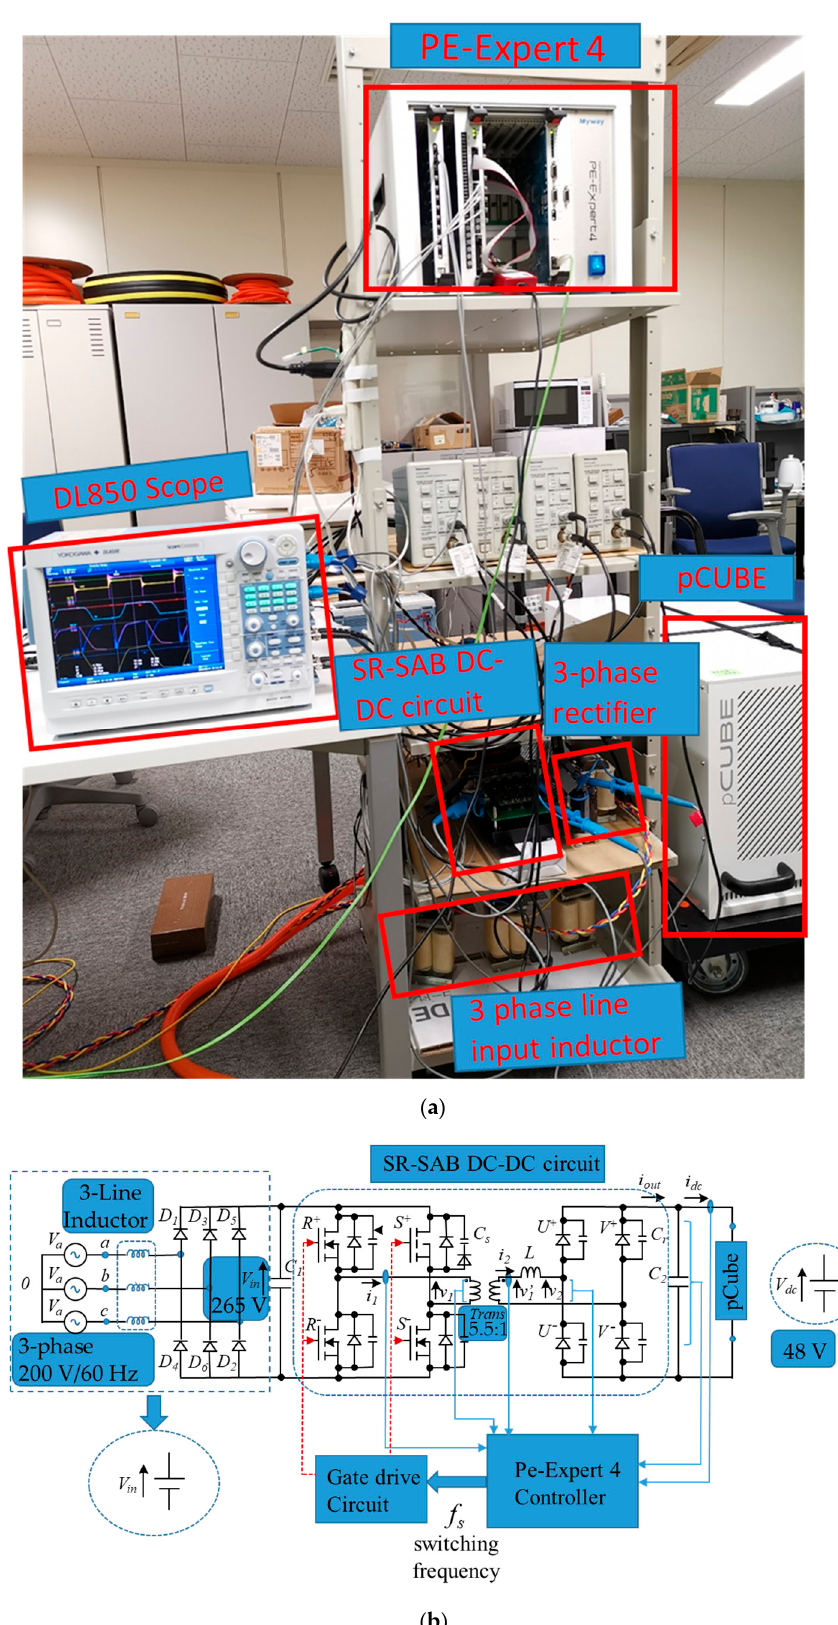
Figure 8. ( a ) Proposed SR–SAB DC–DC 265VDC/48VDC converter experimental setup; ( b ) Proposed SR–SAB DC–DC 265VDC/48VDC converter electrical diagram.